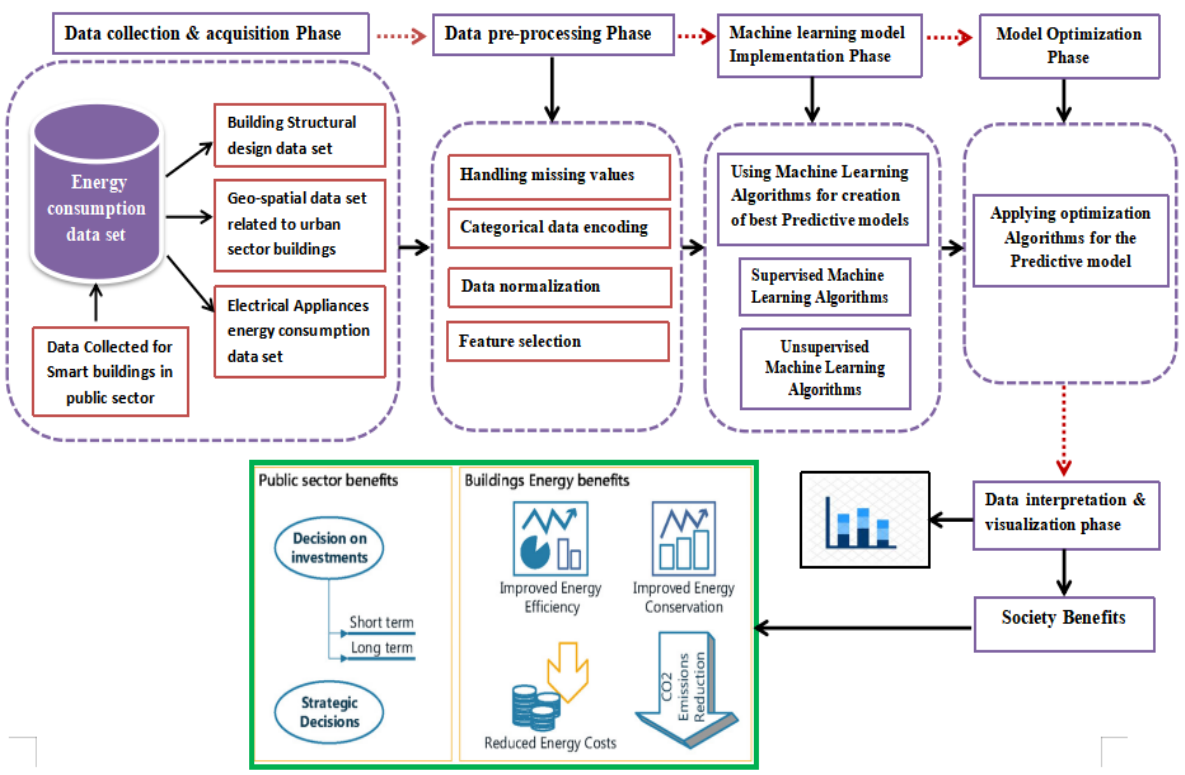
Figure 10. A multi-purpose predictive model for energy efficiency computation in the urban sector.